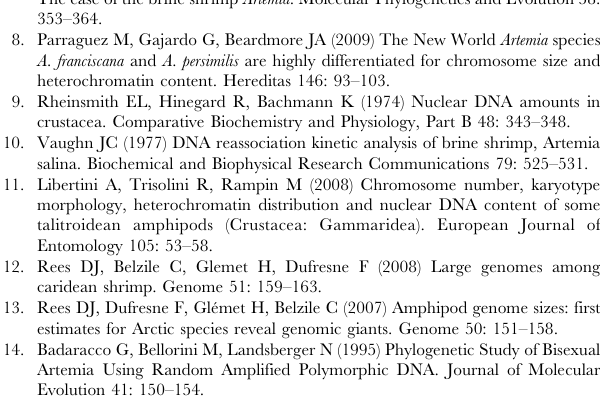
Table S1 List of the 65 primer combinations used for AFLP analysis 1 E: Eco RI primer with three selective bases; M: Mse I primer with three selective bases (1, 2,